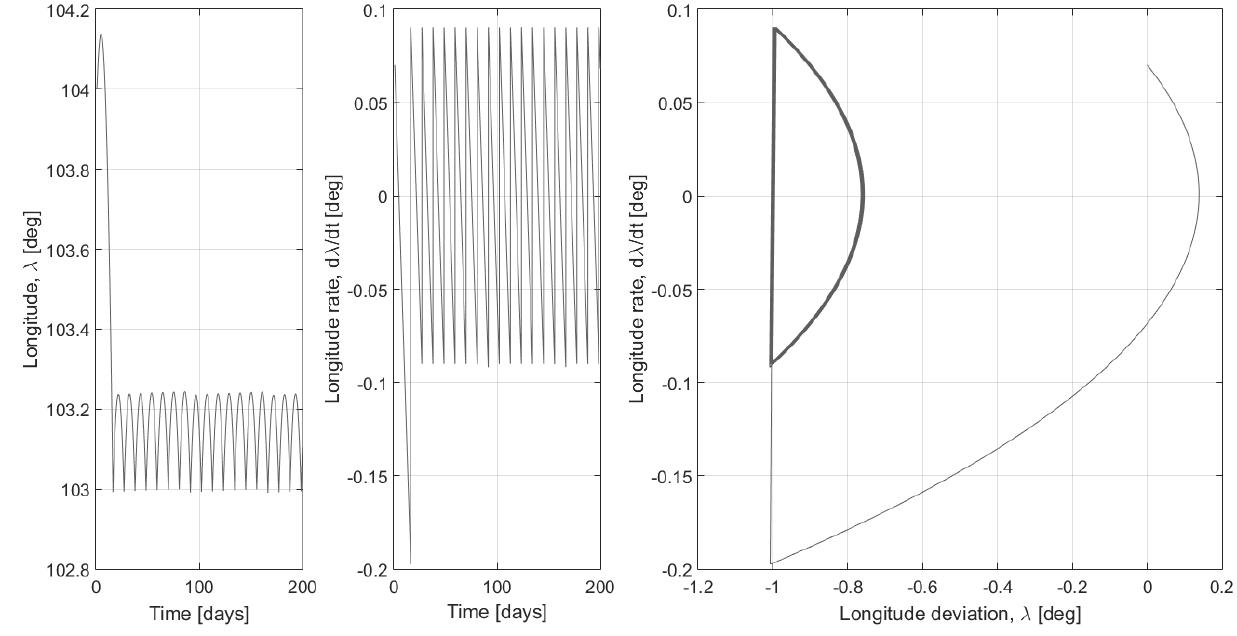
Figure 4. Simple control scheme using incorrect thrust near the unstable node with ¨ λ < 0